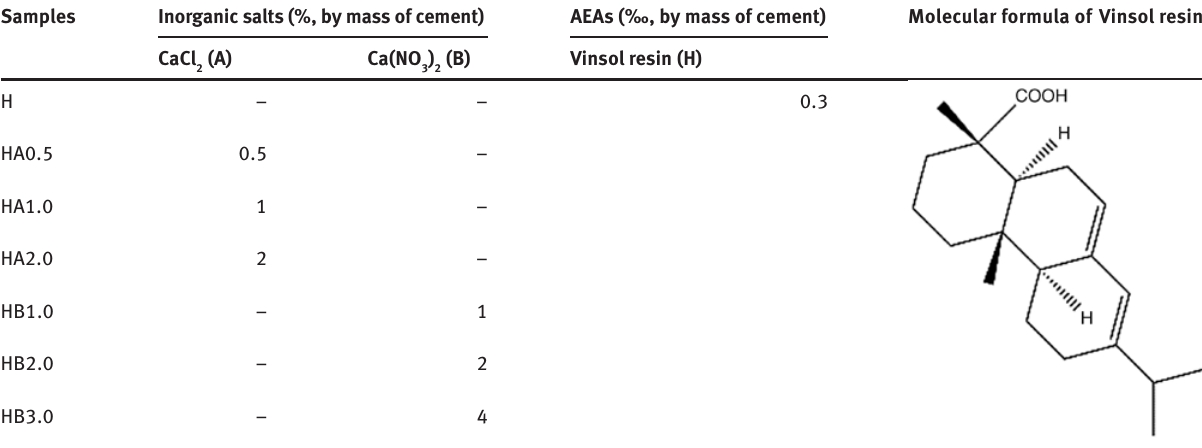
Table 1: Usage of salts and AEAs. Samples Inorganic salts (%, by mass of cement)